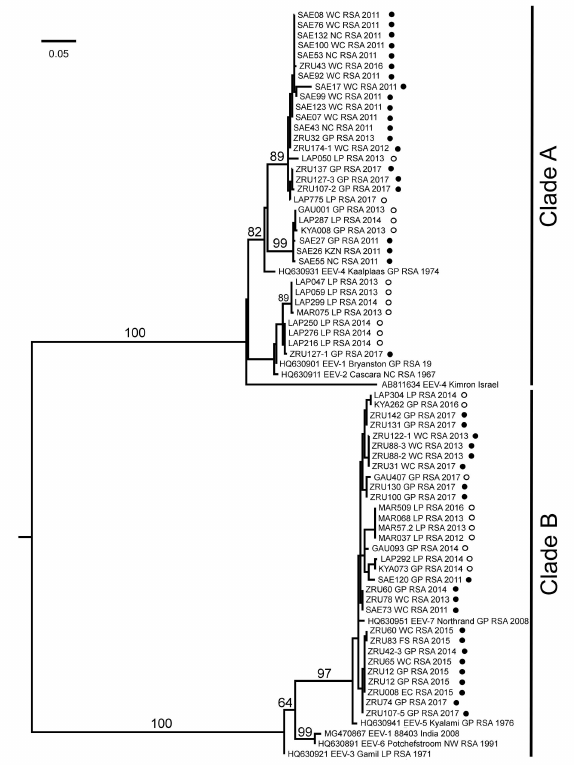
Figure 4. Maximum likelihood phylogram of the partial NS3 gene (332 nucleotides, taxa = 73, model: GTR+G, rooted at mid-point) of equine encephalosis virus strains detected in horses (filled circles) (accession numbers MN921084-MN921120) and midges (open circles) (accession numbers MN271001- MN271022). Sample names consist of the province from which the sample originated (GP: Gauteng, WC: Western Cape; NC: Northern Cape; EC: Eastern Cape; LP: Limpopo; KZN: KwaZulu-Natal; NW: North West FS: Free State), country (RSA: South Africa) and year of